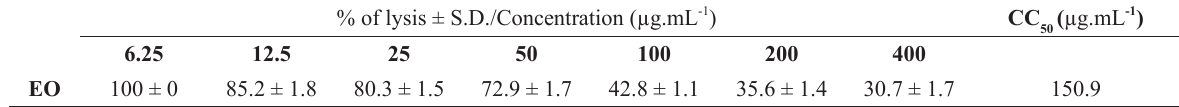
Cytotoxic activity of essential oil from Protium ovatum